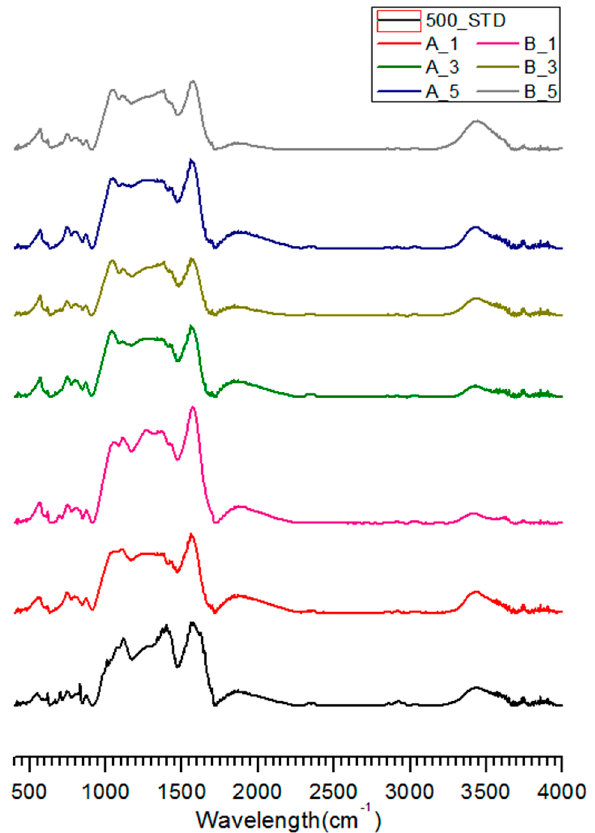
◦ C before and after